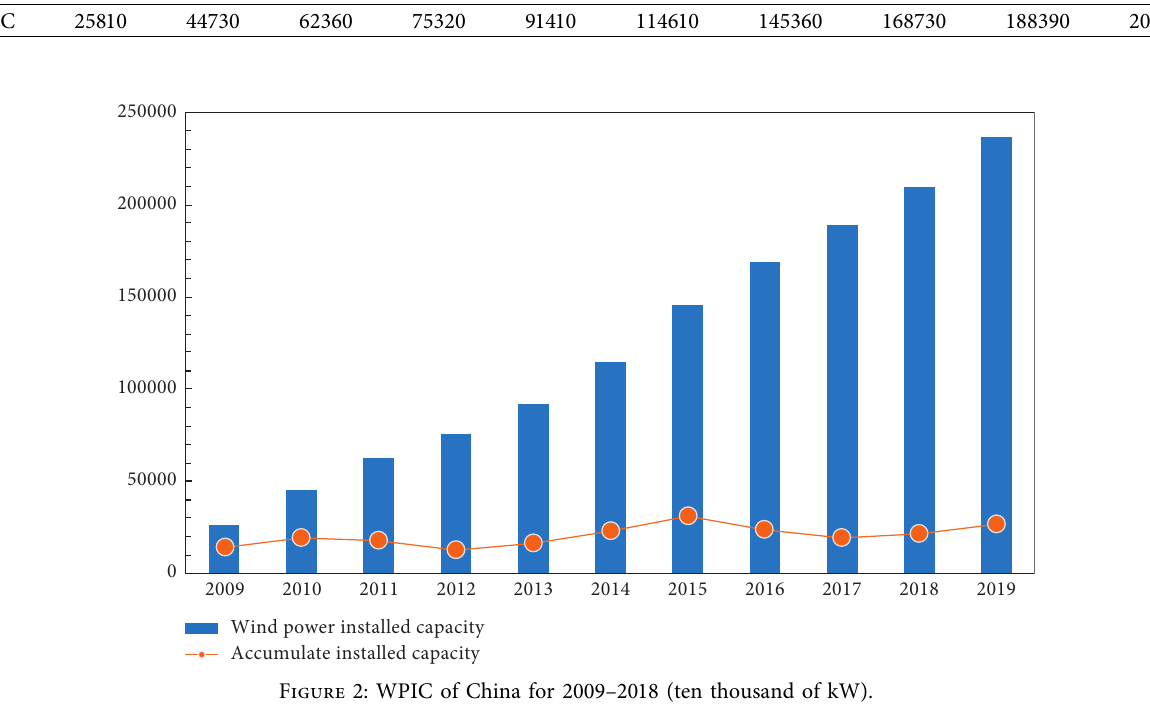
Figure 2: WPIC of China for 2009–2018 (ten thousand of kW).